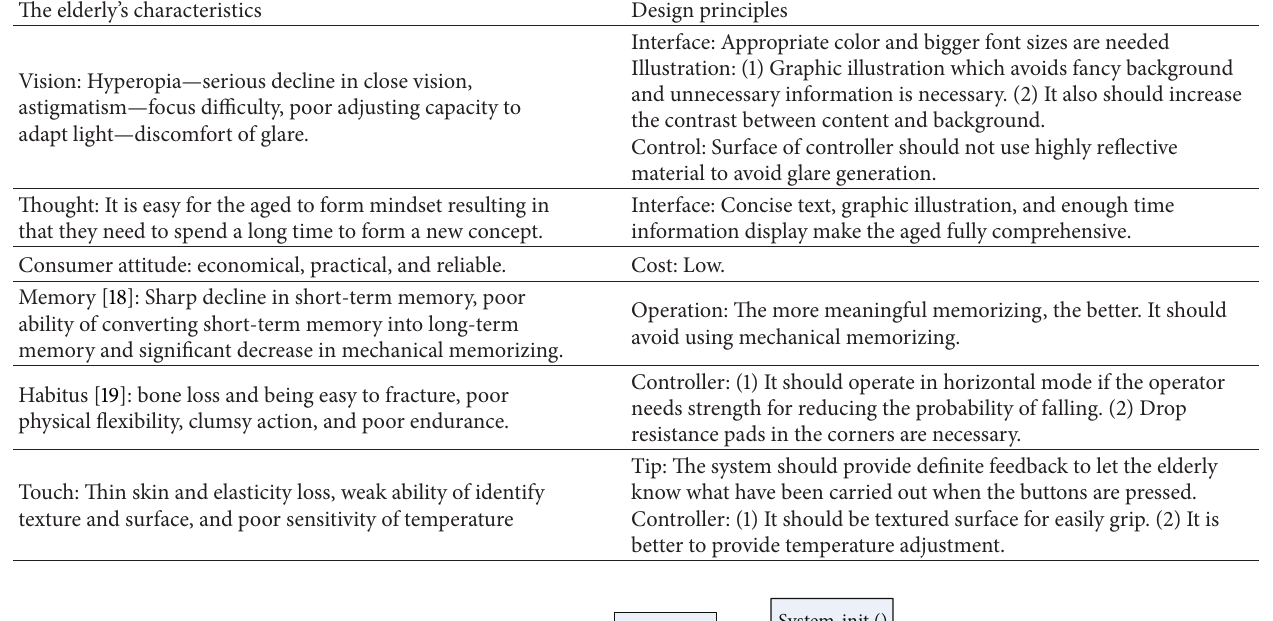
Table 2: Design principles by analyzing the elderly’s physical and psychological characteristics.